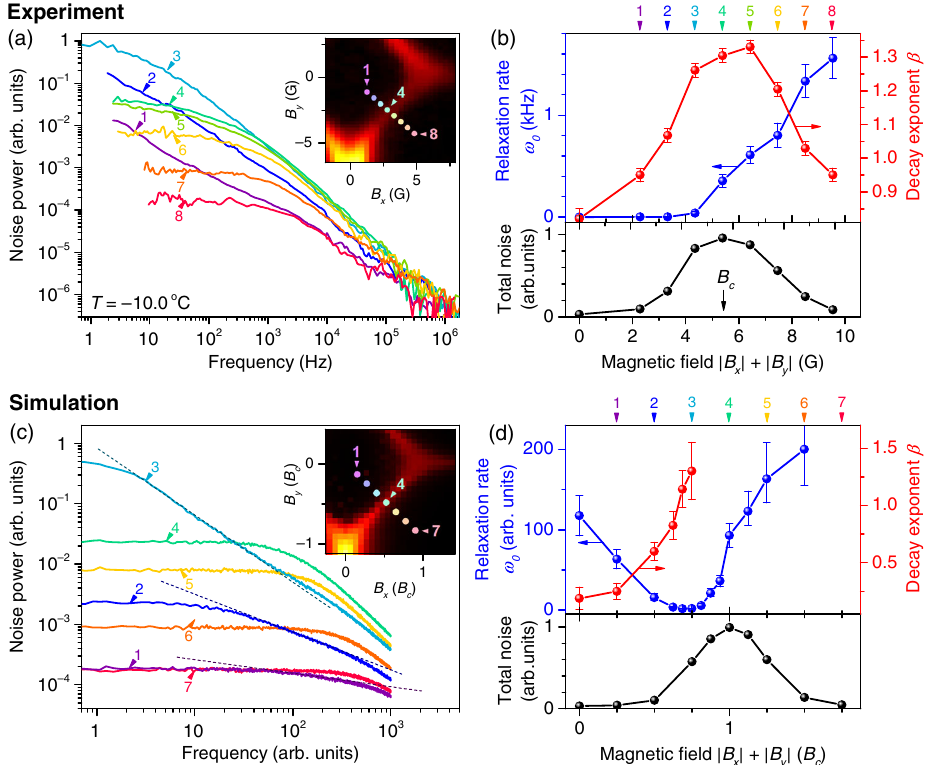
FIG. 5. Magnetization noise spectra through the monopole plasma regime. (a) Measured noise spectra along the indicated path (keeping j B x j ¼ j B y j ), which traverses between type-I and type-II order. Here, T ¼ − 10 . 0 °C. (b) Extracted relaxation rates ω 0 (blue points), decay exponents β (red points), and total noise power (black points). Note that β exhibits a maximum and is closest to a value of 2 when B ¼ B c , indicating that the monopoles exhibit their most-uncorrelated (most-diffusive) dynamics in the plasmalike regime where their density is largest. (c,d) Corresponding computed noise spectra from Monte Carlo simulations and extracted parameters ω 0 , β , and total noise. Dashed lines are guides to the eye, highlighting power-law decays. The total integrated noise is peaked when type-I and type-II vertex energies are degenerate, i.e., in the monopole plasma regime that occurs at the crossover field B c . By contrast, simulations show that ω 0 exhibits a minimum when the ASI orders antiferromagnetically (spontaneous type-I ordering), which occurs at an applied field that is slightly less than B c when T > 0 (see also Supplemental Material Fig. S5